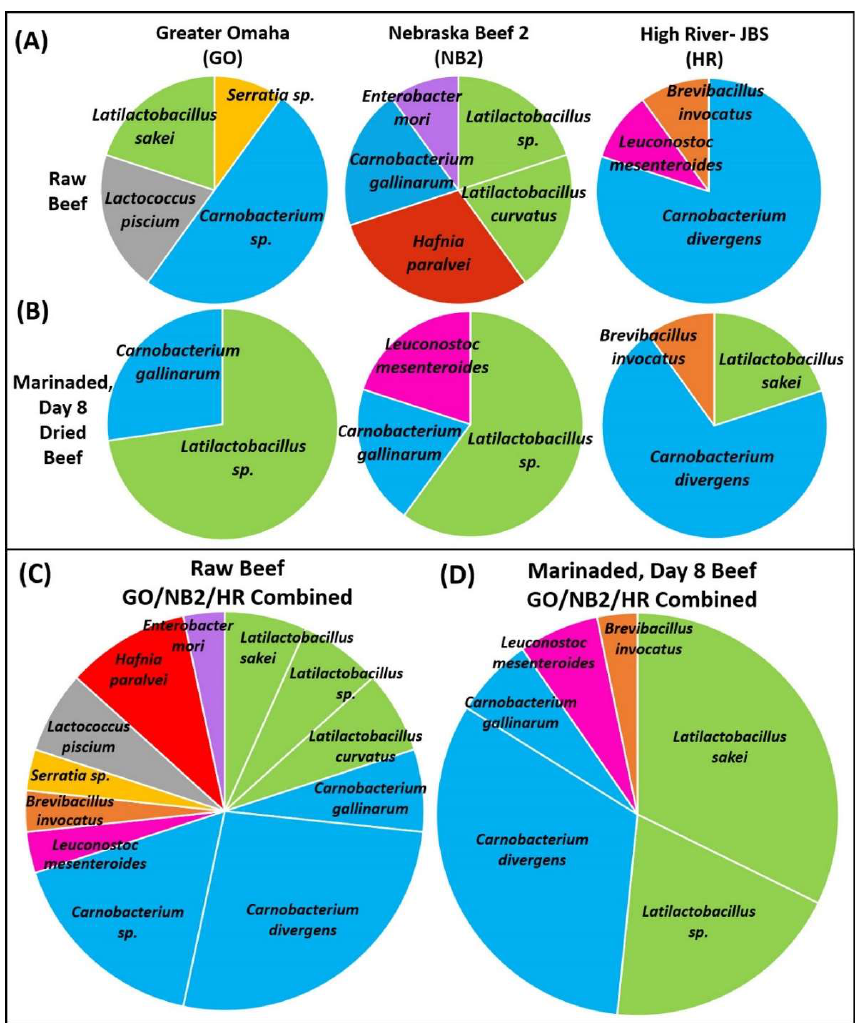
Figure 1. Culture-dependent microbiome analysis. Bacteria isolated and identified using 16S rRNA PCR and sequencing from duplicate biltong trials with beef from each of the 3 processors: ( A ) raw beef and ( B ) biltong that had been marinaded and dried for 8 days. Pie chart analysis of all isolates from the three processors combined from ( C ) raw beef and ( D ) day 8 dried